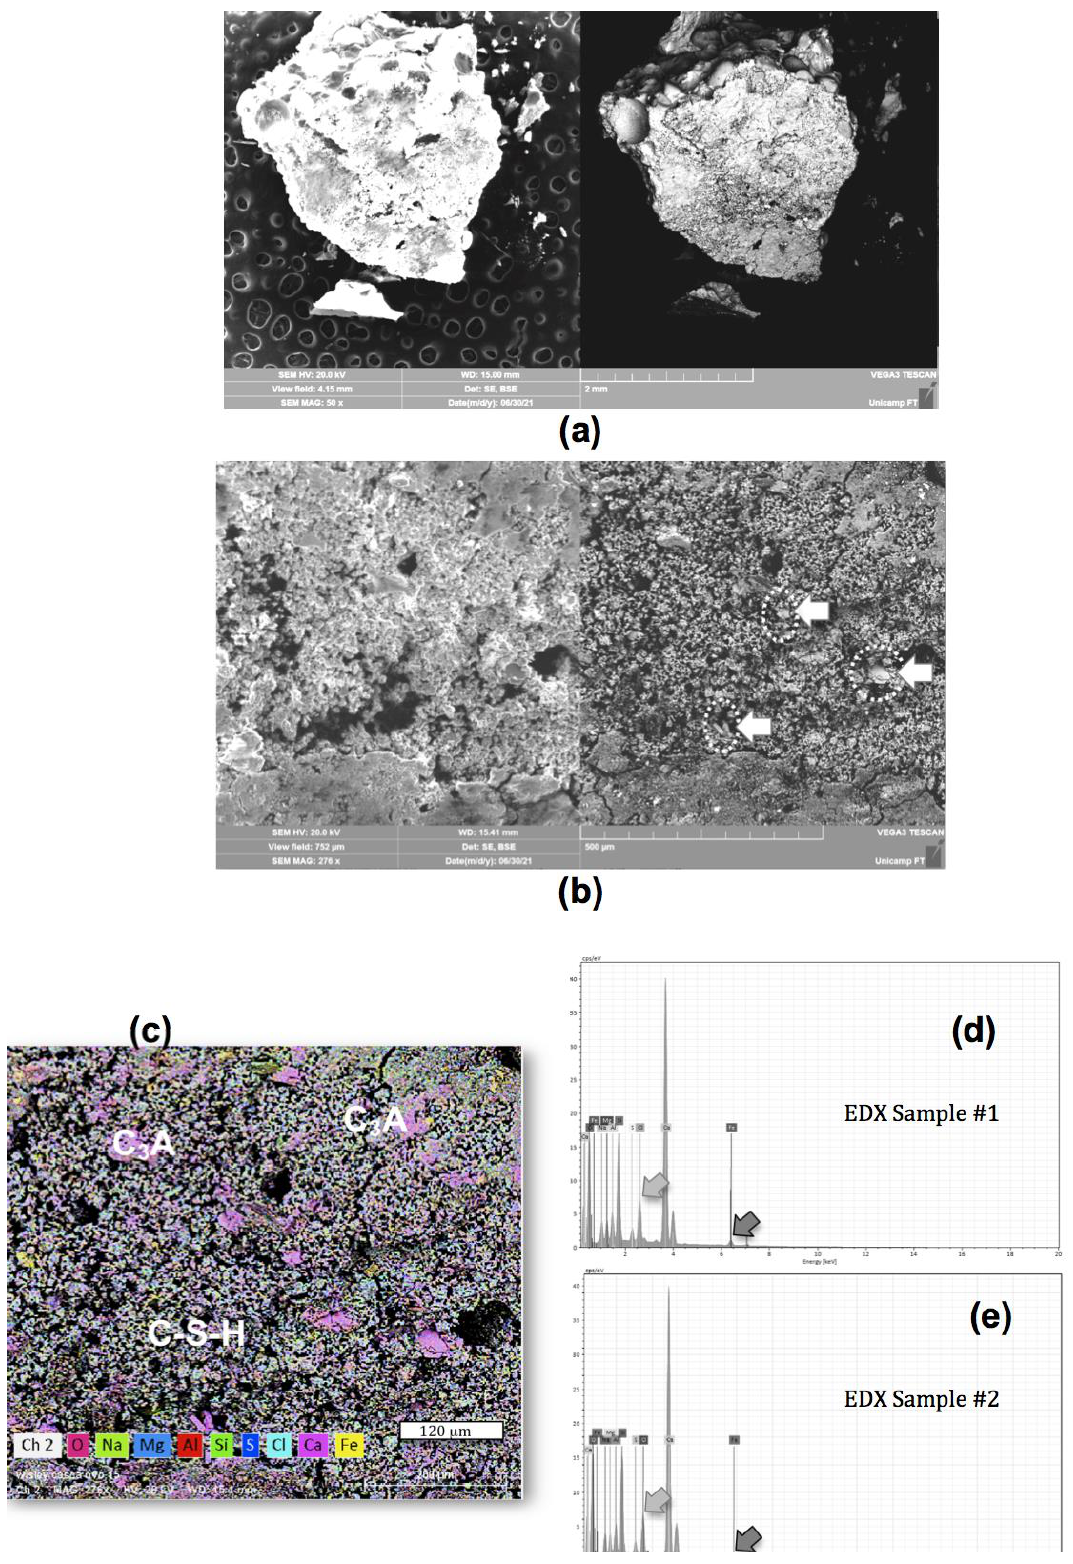
Figure 14. ( a , b ) typical SEM micrographs of the CEM sample and ( c – e ) elemental map and EDX diagrams (duplicate) of the CEM sample, respectively. Eggshell particles are identified by white arrows inside ( b ).